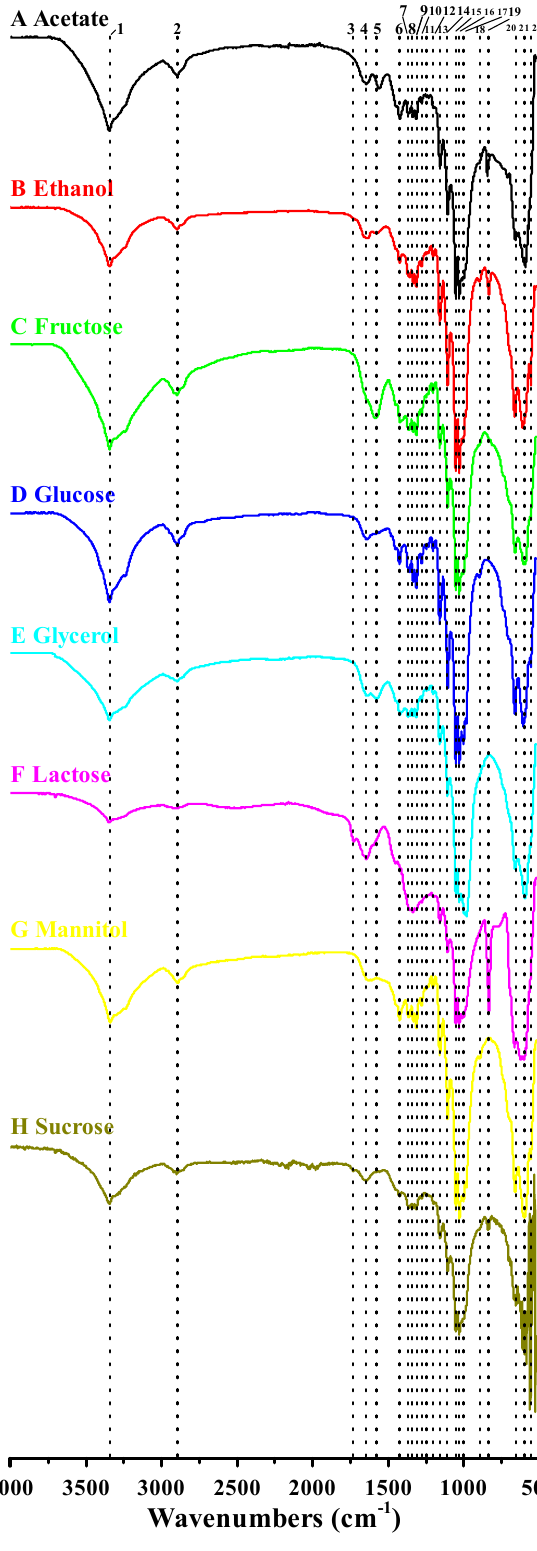
Figure 4. Comparative Fourier transform infrared (FTIR) analysis of the BC produced by Komagataeibacter sp. W1 grown in media spiked with various carbon sources. The analysis was conducted on a Nicolet iS5 in the Attenuated Total Reflectance (ATR) mode with 32 scans per measurement between 400 and 4000 cm − 1 . The detailed information of peaks 1–22 is given in Table 3.